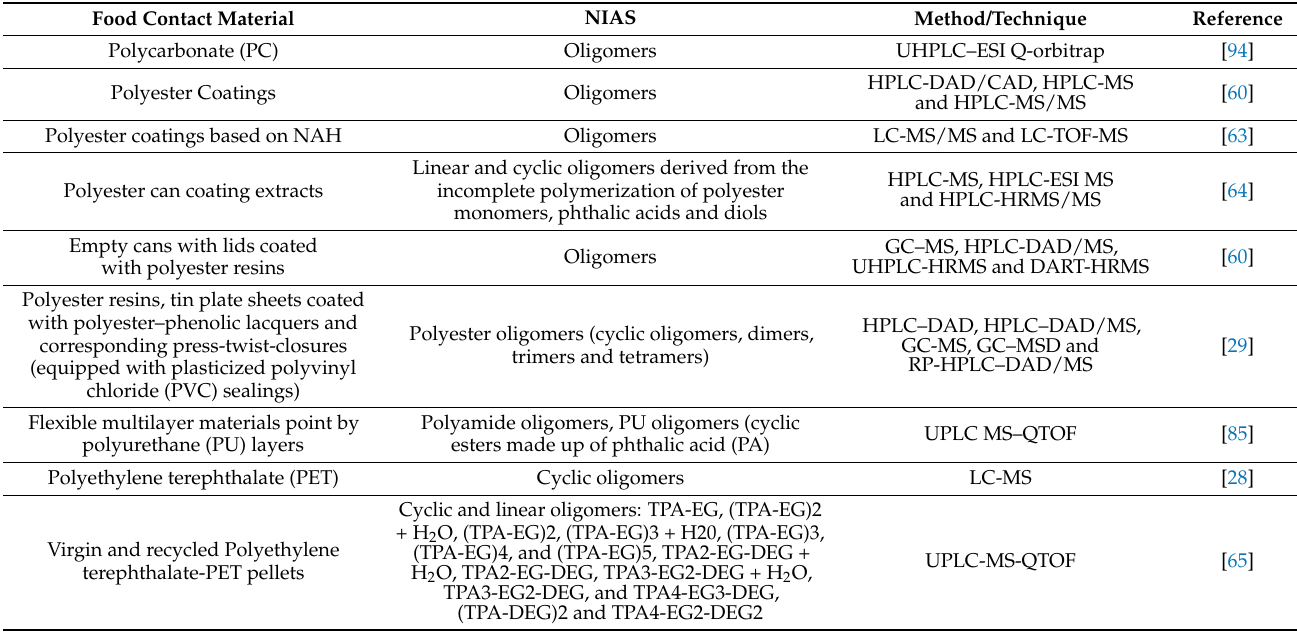
Table 2. Studies published in the literature on oligomers (NIAS) Identification in different plastic food packaging. Food Contact